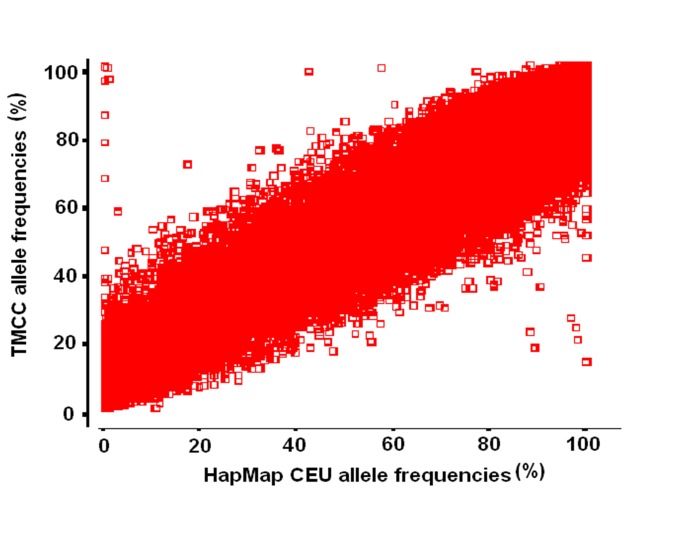
Plot of TMCC vs HapMap CEU PAFs.